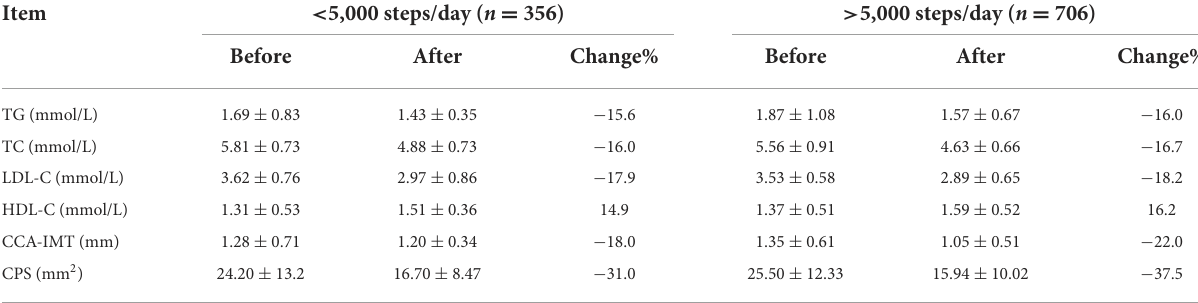
TABLE 7 Comparison of the effects of NK on lipid profile and progression of atherosclerosis in sedentary and non- sedentary participants. Item < 5,000 steps/day ( n = 356) > 5,000 steps/day ( n = 706) Before